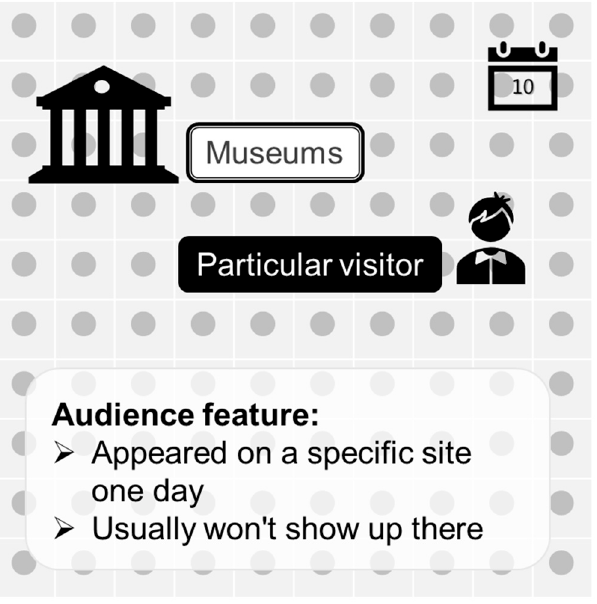
Figure 2. Audience feature in Case